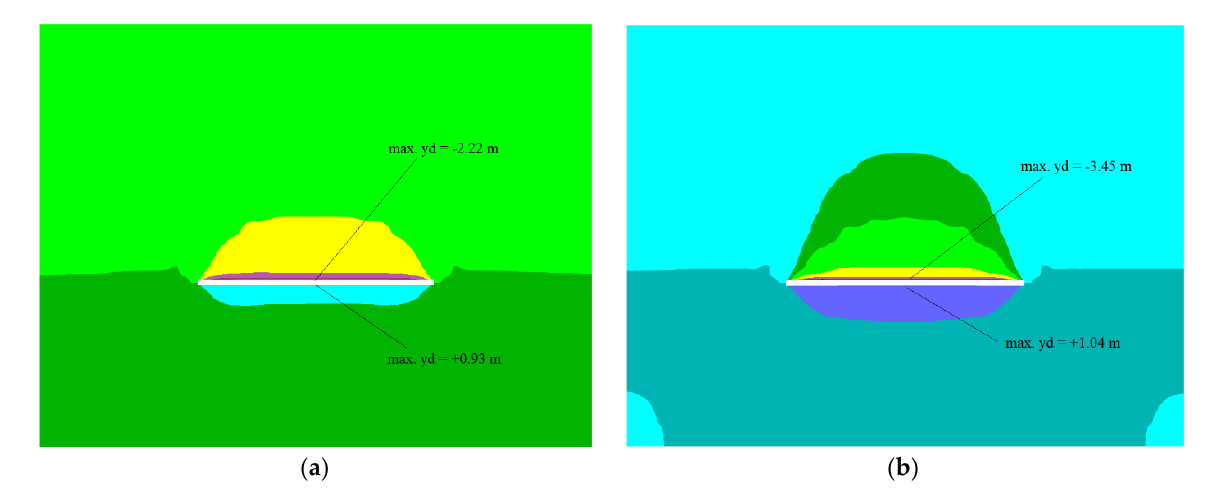
Figure 15. Vertical roof and floor displacements after the extraction of a 4.2 m-thick longwall at various calculation steps: ( a ) 1000, ( b ) 1500.